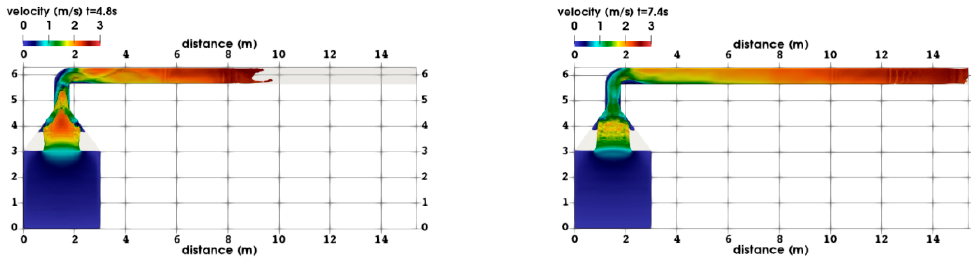
Figure 3. Top view snapshots of the SPH modelled tailings slurry flow motion in the flume.